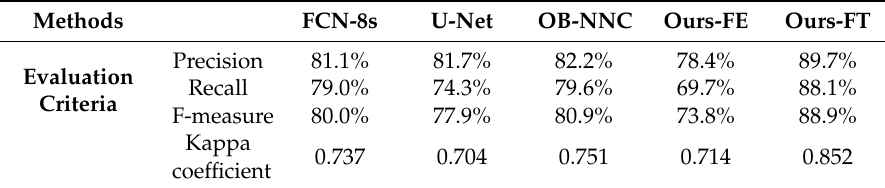
Table 4. Quantitative comparison between methods using conventional object-based image analysis (OBIA), FCN-8s, U-Net, and our methods at the pixel level.